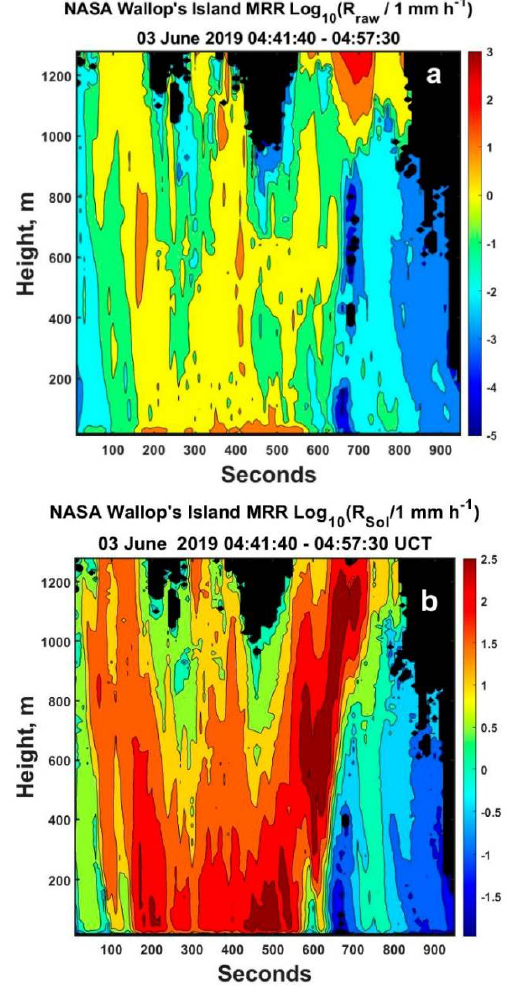
Figure 15. Time–height plots of the rainfall rates ( a ) from the MRR processor ( R raw ) and ( b ) those after accounting for vertical air speed ( R Sol ). Compared to ( a ), note the significantly larger values throughout ( b ), which are consistent with the structure of Z in Figure 13. Black denotes no power.